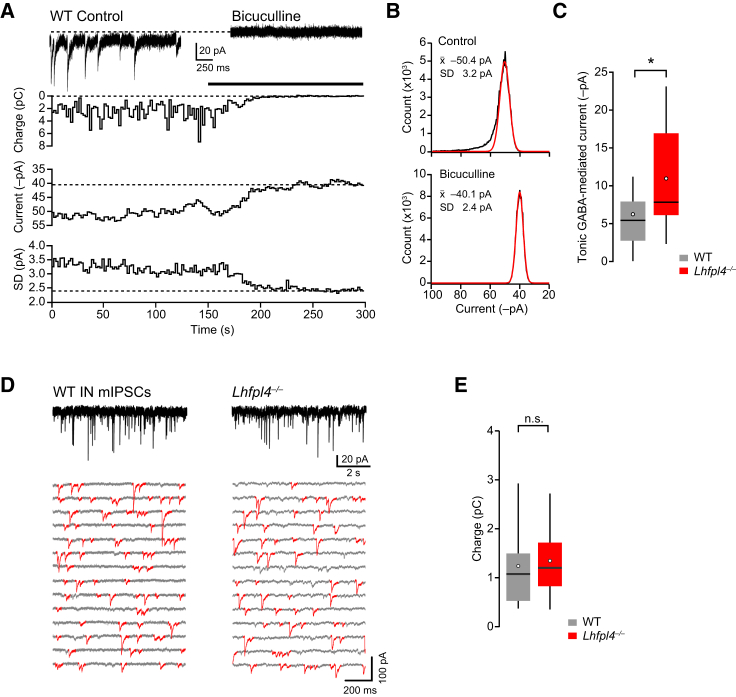
GABA-Mediated Tonic Current in Pyramidal Cells and mIPSCs in Interneurons Are Not Disrupted by LHFPL4 Deletion(A) Representative record (−70 mV) from a WT CA1 pyramidal neuron showing the block of mIPSCs and the shift in holding current produced by bath application of bicuculline. Lower panels show the time course of the synaptic charge transfer, mean holding current, and its SD (see Supplemental Experimental Procedures).(B) Representative all-point amplitude histograms from 1-s segments in the control period (upper) and in the presence of bicuculline (lower). Red lines indicate fits of a single-sided Gaussians to the most positive current values yielding the mean and the SD. The mean was taken as the baseline current for that segment and subtracted from the record. The integral of the subtracted current provided the charge carried by the synaptic events.(C) Pooled data showing increased tonic GABA-mediated current in CA1 pyramidal neurons (from 6.2 pA ± 1.3 pA to 11.0 pA ± 1.7 pA; n = 22 WT and 15 Lhfpl4−/− cells; p = 0.037, Welch t test).(D) Representative recordings of mIPSCs (−70 mV) in non-pyramidal cells (INs, presumptive interneurons) from a WT mouse (left) and an Lhfpl4−/− mouse (right). Lower panels are representative sections of recordings (contiguous 1-s segments) showing no change in fast mIPSCs (red). Records digitally filtered at 2 kHz for illustration purposes.(E) Pooled data showing the lack of effect of LHFPL4 deletion on mIPSC-mediated charge transfer in presumptive interneurons (1.24 pC ± 0.39 pC and 1.34 pC ± 0.34 pC; n = 6 WT and 6 Lhfpl4−/− cells; p = 0.84, Welch t test).Box-and-whisker plots indicate median (line), 25th–75th percentiles (box), the range of data within 1.5 × IQR of the box (whiskers), and mean (open circles). ∗p < 0.05.See also the Supplemental Experimental Procedures.